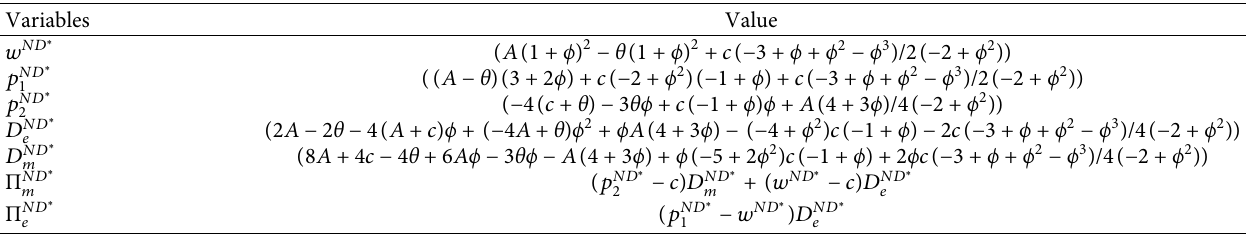
Model selection: ND represents the online direct+online distribution sales model without block chain technology, NW represents the online direct+online distribution sales model with block chain technology, YD represents the online direct+online delegation sales model without block chain technology, and YW represents